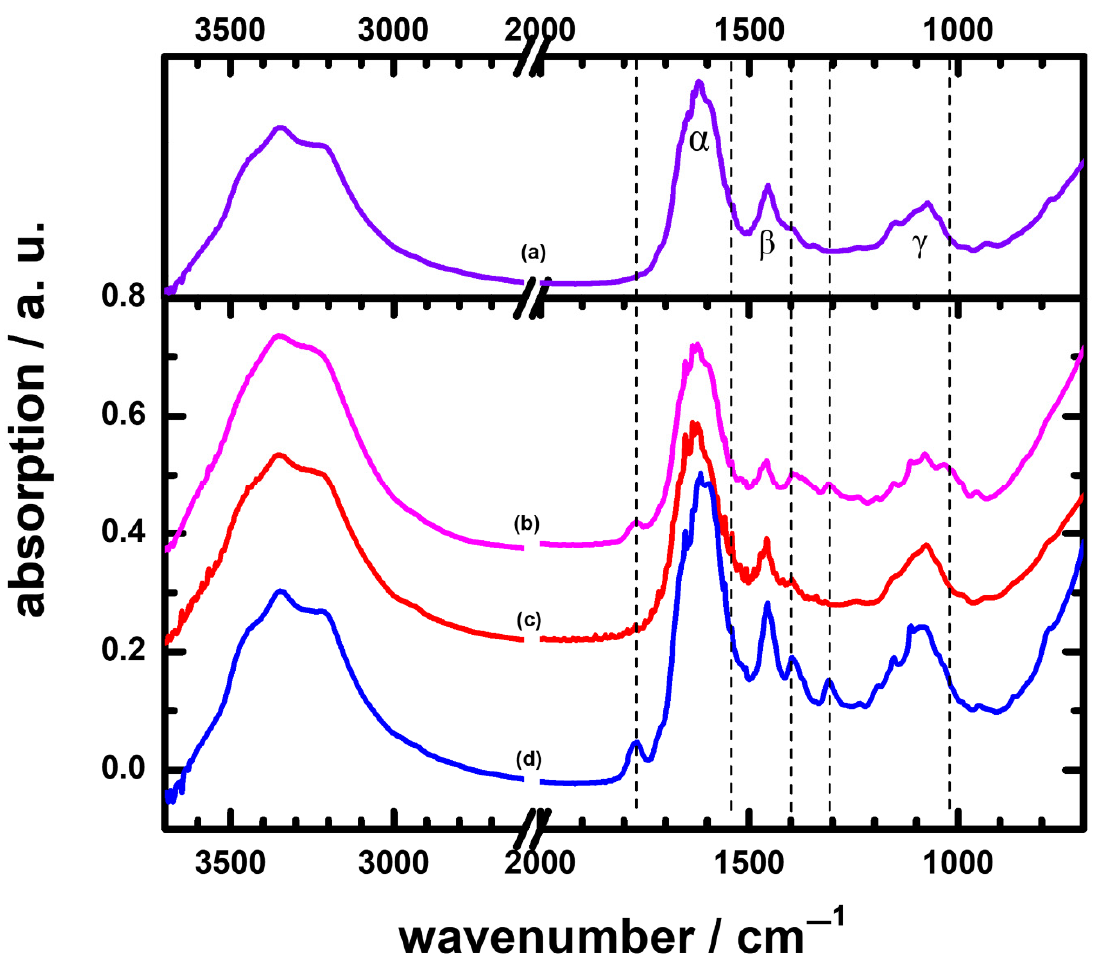
Figure 3. ATR-FTIR spectra of: ( a ) averaged 11 non-UTIs, assigned as IR av/non ; and UTI group and cultured bacteria: ( b ) E. faecium (patient No. 1); ( c ) E. coli (patient No. 5); ( d ) P. aeruginosa (patient No. 7).